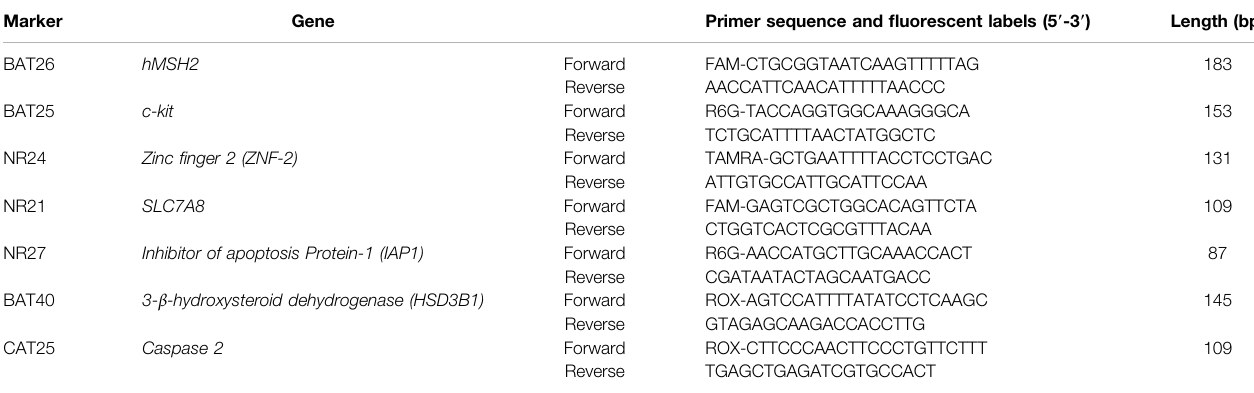
TABLE 3 | Oligonucleotide sequences and fl uorescent labels